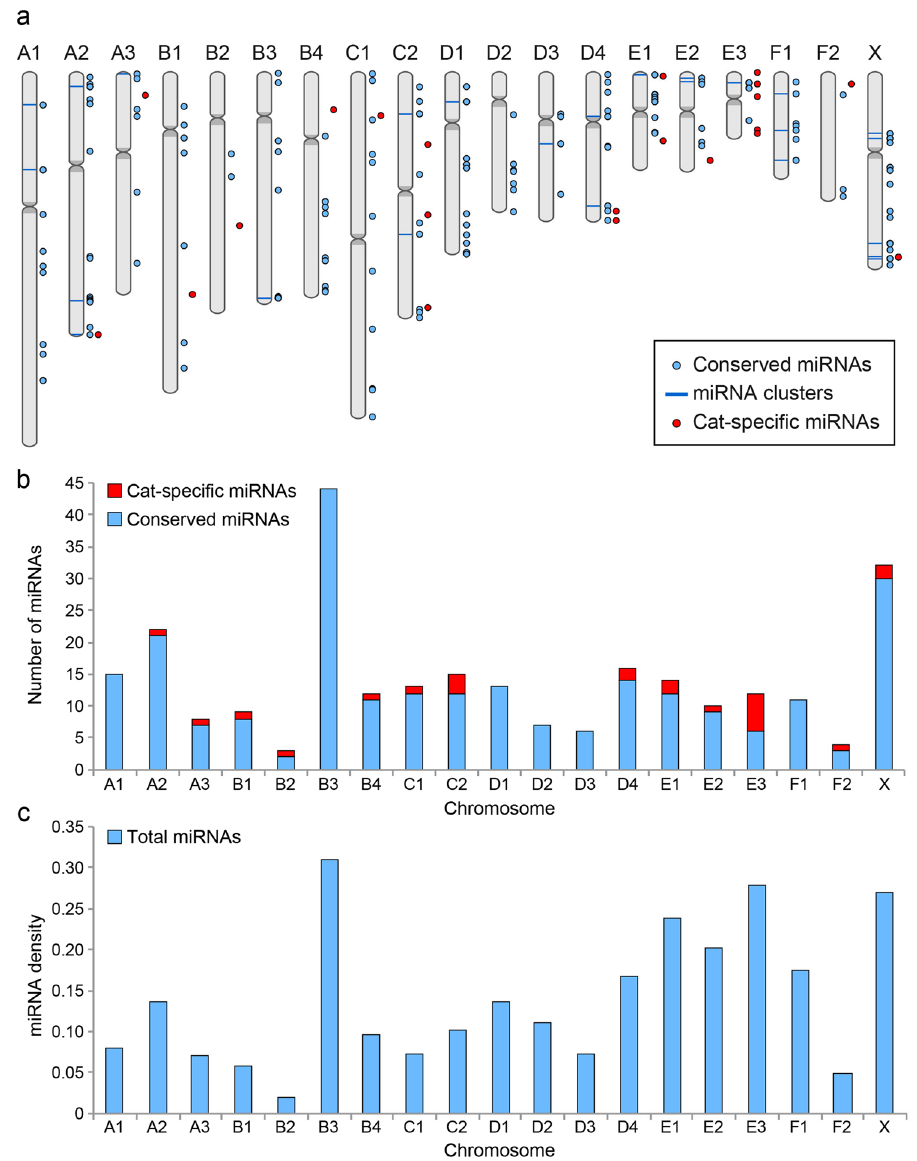
Figure 3. Genomic distribution of the identified miRNAs. ( a ) The figure shows the chromosomal distribution of cat-specific (red) and conserved (light blue) miRNAs. Clusters are represented by light blue bars. ( b ) The stacked column chart shows the total number of miRNAs per chromosome, highlighting the fractions of conserved (light blue) and novel, cat-specific (red) ones. Chromosomes A1, B3, D1, D2, D3 and F1 contain no cat-specific miRNAs, while Chromosome E3 has the highest number and percentage of cat-specific miRNAs (6 and 50%, respectively). ( c ) The chart shows the miRNA density per chromosome, calculated as the number of miRNAs per Mbp (Megabase